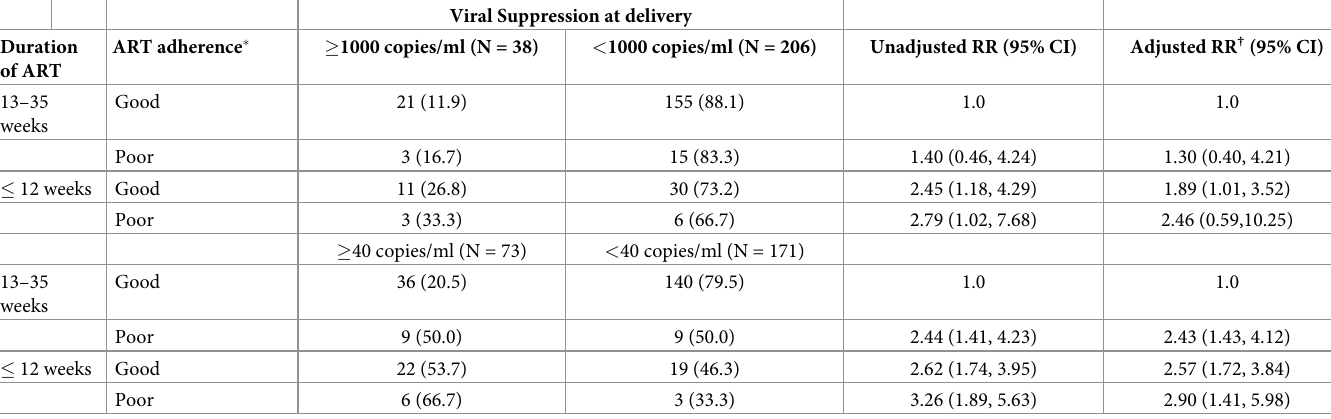
Table 5. Associations between duration of ART at delivery and viral suppression at delivery stratified by levels of ART adherence. Viral Suppression at